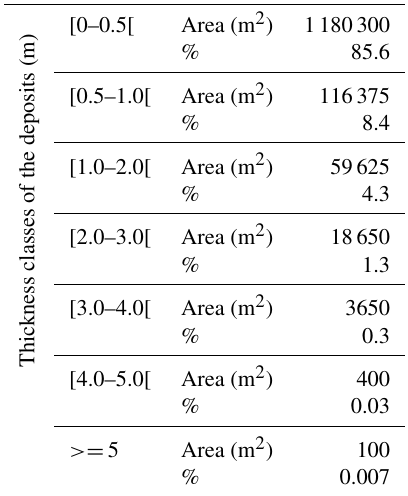
Table 8. Classification of the deposits thickness and occupied area (Scenario B).